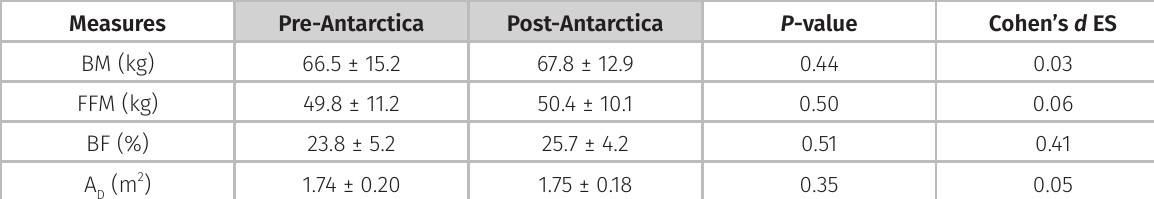
Table I. Physical characteristics of the volunteers in the pre-Antarctica and post-Antarctica trials. Measures